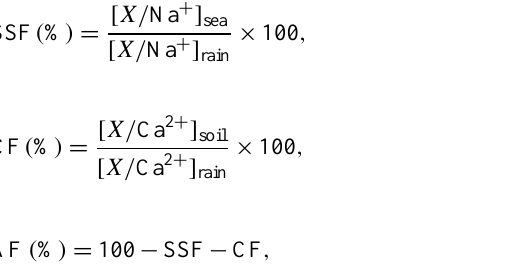
Figure 2. Seasonal dynamics of ion concentrations (unit: µeqL − 1 ) and precipitation (unit: mm) at five remote sites in the TP. The sam- pling times of the five sites were as follows: Southeast Tibet